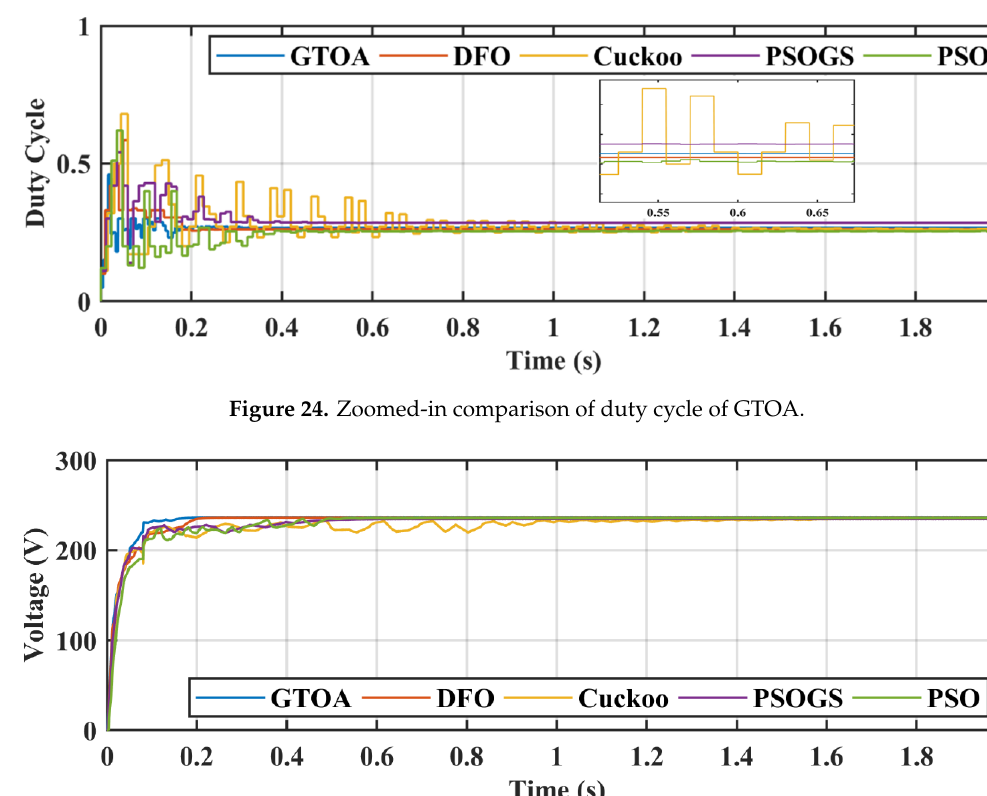
Figure 25. Comparison of voltage transients of GTOA.